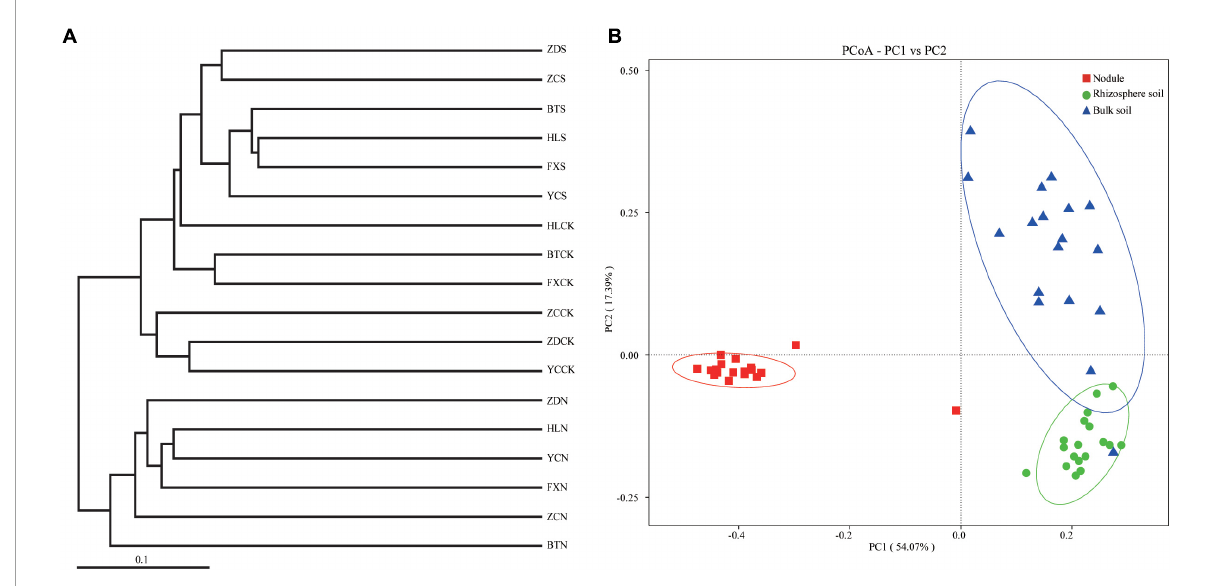
FIGURE6 Beta diversity analysis. (A) is cluster pedigrees of different flora within the different samples based on unweighted UniFrac distances. (B) is principal coordinate analysis (PCoA) based on the relative abundance of bacterial OTUs.